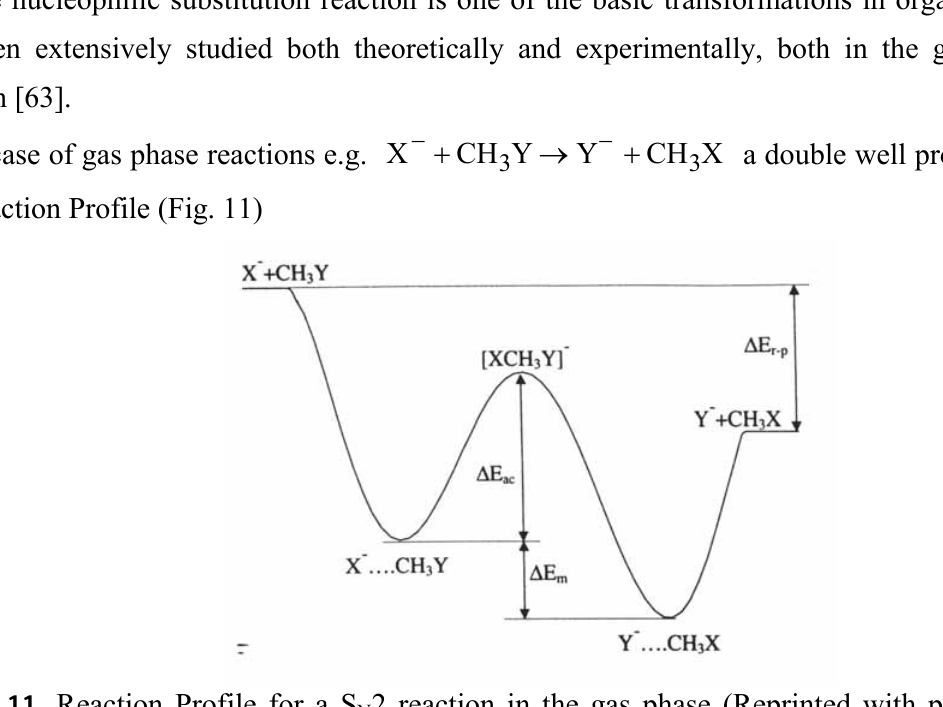
) versus the Kirkwood function Figure 10. Plot of ∆ ( ∆ N R (Reprinted with permission by the American Chemical Society - Reference [61]).